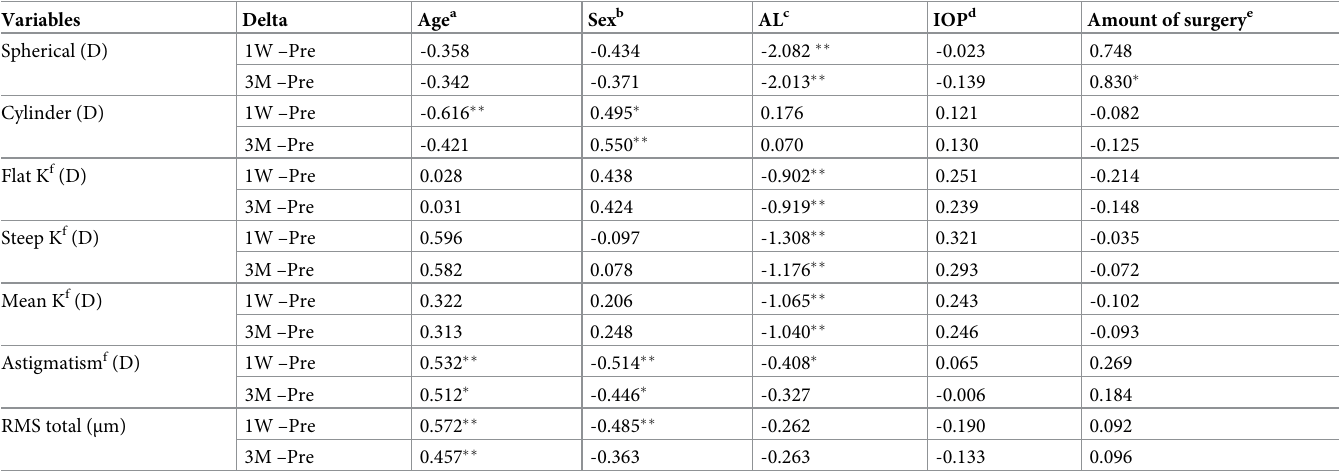
Table 1. Result of multiple linear mixed-effect model analysis of